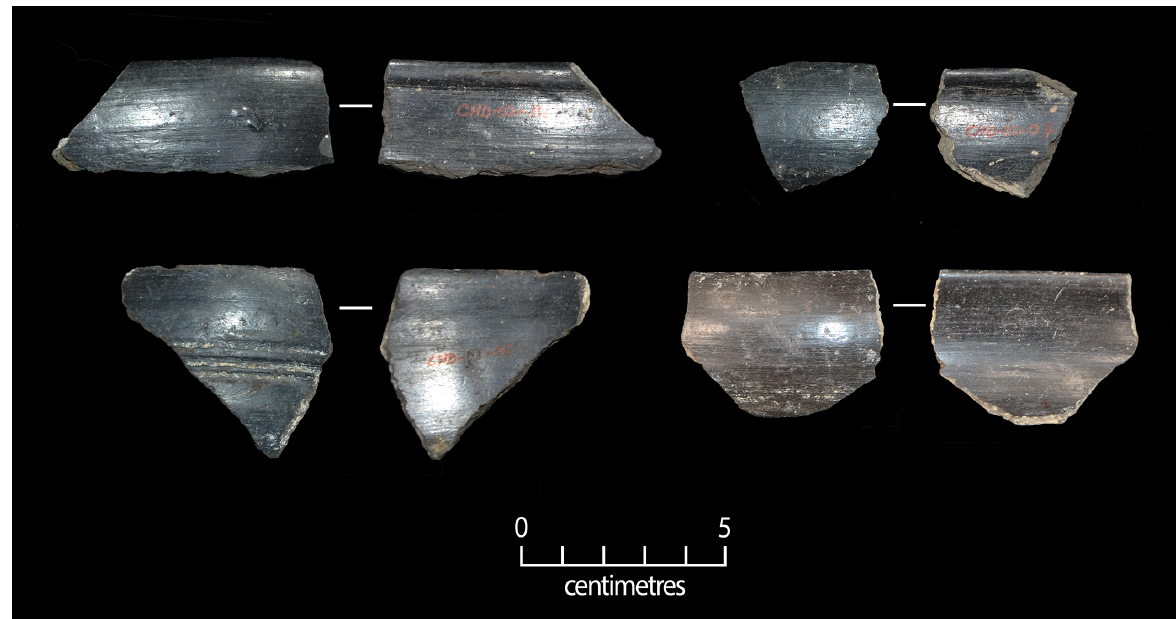
Figure 25: External and internal surfaces of four Class 7 variant 2